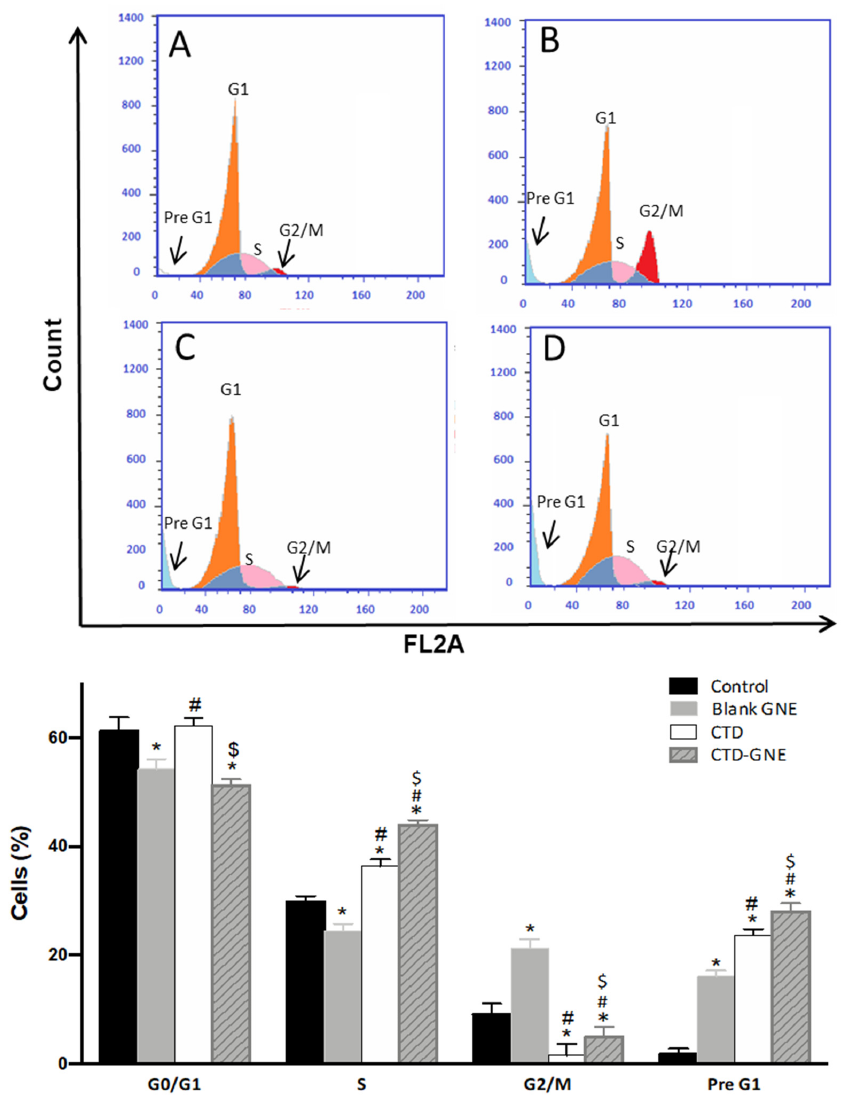
Figure 6. Analysis of apoptosis via the Annexin-V FITC Staining Kit in A549 cells ( A ) control, ( B ) blank GNE, ( C ) CTD, ( D ) CTD-GNE using a flow cytometry analysis. All data are